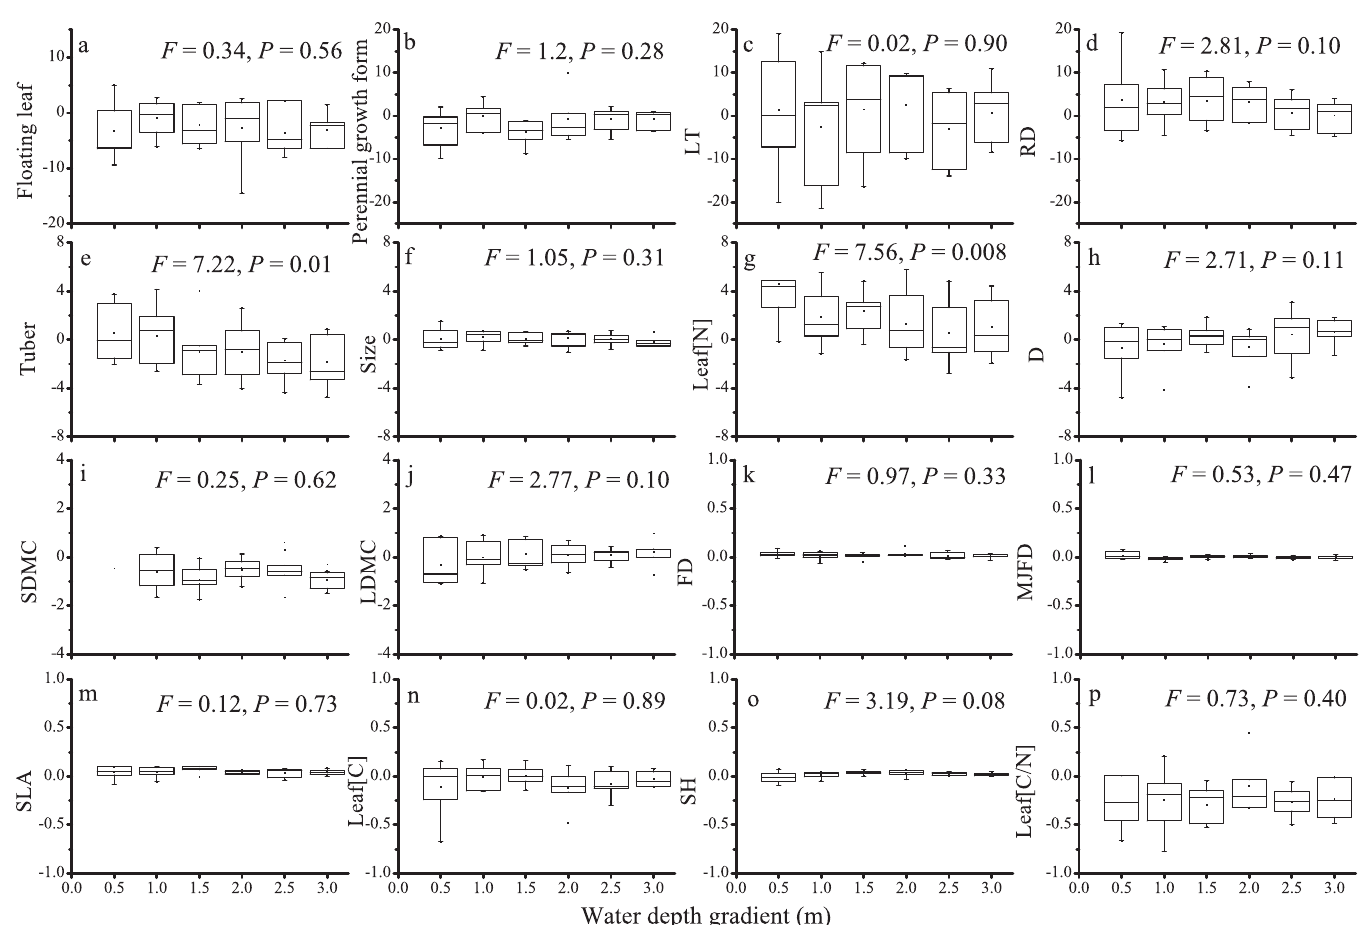
Fig 3. Boxplots showing the differences in λ -values derived the maxent models along water depth gradient for the 16 measured traits of macrophyte species. The F and P values from linear regression analyses are shown. LT: lamina thickness; RD: rooting depth; Leaf [N]: leaf nitrogen content; D: stem diameter; SDMC: stem dry mass content; LDMC: leaf dry mass content; FD: flowering duration; MJFD: mean Julian flowering date; SLA: specific leaf area; Leaf [C]: leaf carbon content; SH: shoot height; Leaf [C/N]: leaf carbon/nitrogen ratio.